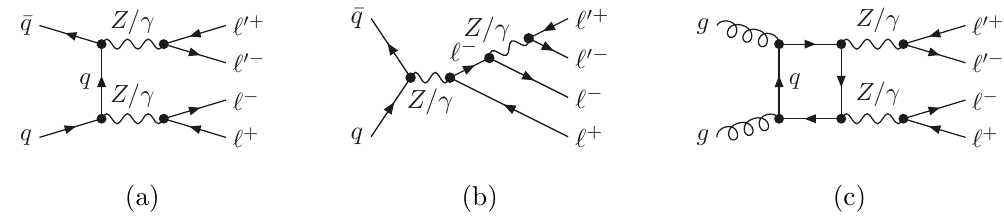
Figure 1 . Sample Feynman diagrams for ZZ production with four charged (cid:12)nal-state leptons: tree-level diagrams of the quark annihilation channel in (a) and (b), loop-induced diagram of the gluon fusion channel in